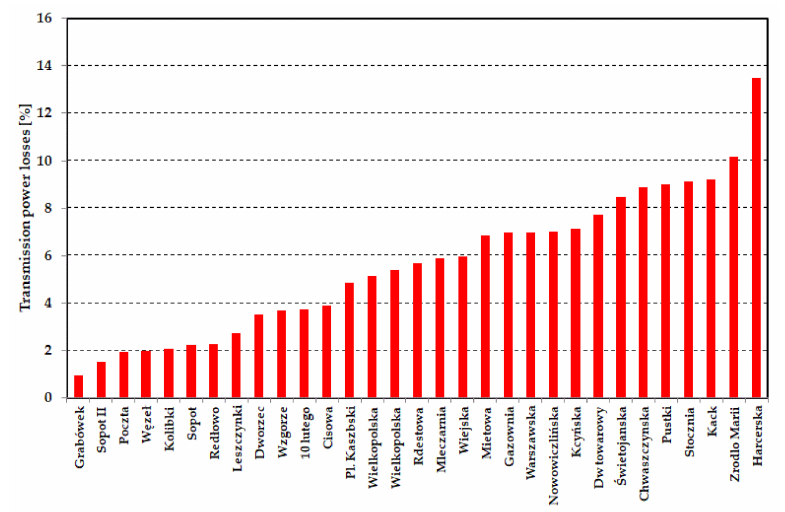
Figure 11. Percentage transmission losses of supply